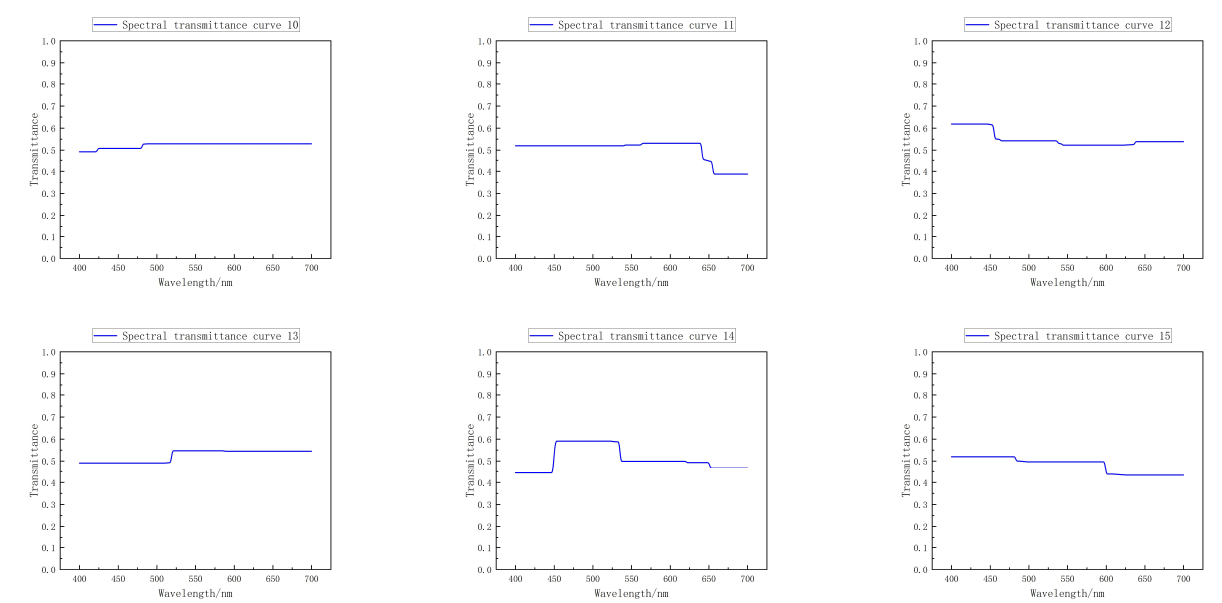
Figure 7. Spectral transmittance curves of all trained optical filters.